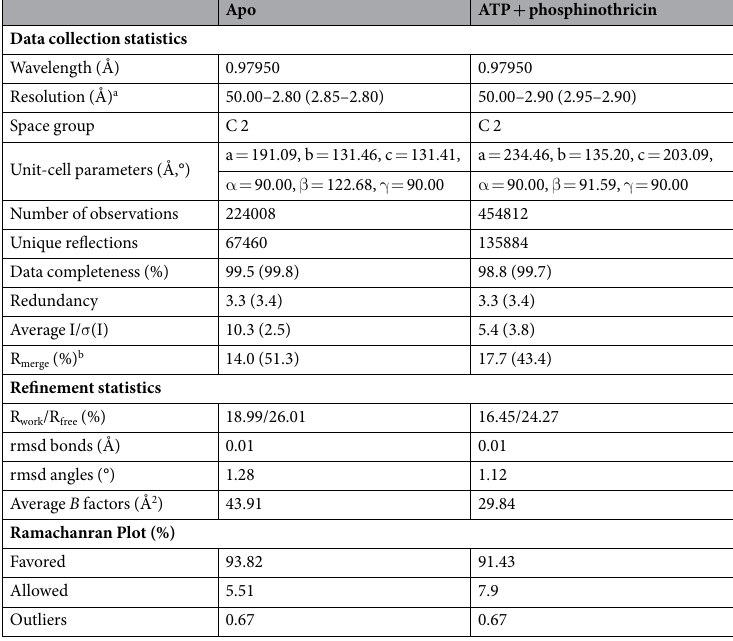
(Table S1.). The adenylation loops had higher r.m.s.d. values, which may be attributed to the disorder of the loop. These results indicated that Hpy GS does not undergo a large conformational change upon substrate binding. Active site of Hpy GS.